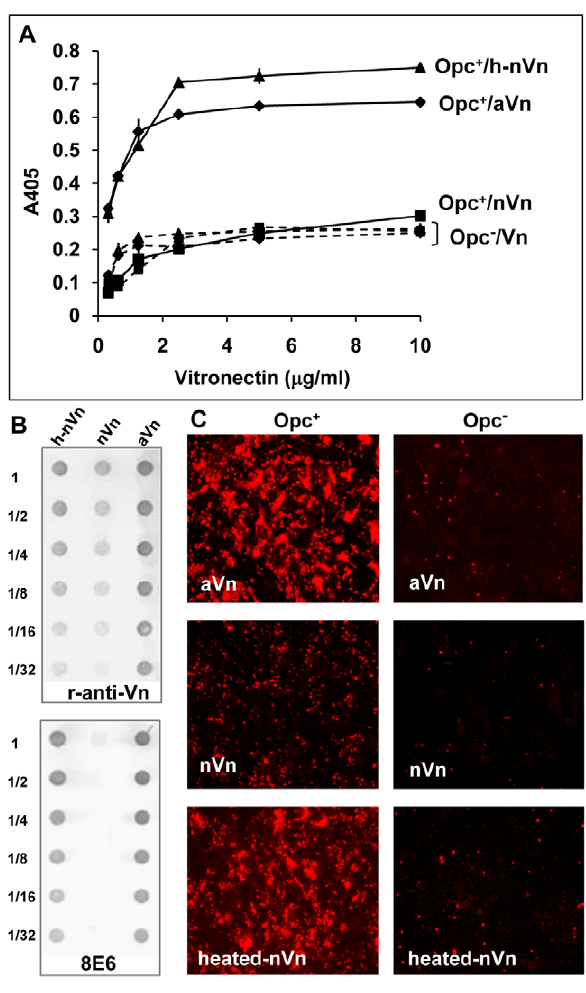
Figure 3. Deliberate modification of nVn conformation increases Opc–expressing meningococcal interactions with Vn and with HBMECs. (A) Purified native Vn (nVn) was subjected to limited heat denaturation to relax its folded conformation and reveal the mAb 8E6 binding site. To assess the levels of binding of Opc + Nm to nVn, heated nVn (h-nVn) and the serum-derived heparin-purified activated Vn preparation (mAb 8E6 binding form), these proteins were overlaid on to immobilised Opc + and Opc 2 isolates of strain C751 and Vn binding determined using polyclonal anti-Vn antibody. As bacteria lacking Opc exhibited the same level of binding to all vitronectin preparations, these are labelled as (Opc 2 /Vn broken lines). (B) The vitronectin samples used for ELISA were also analysed for their activation status using the mAb 8E6 and the polyclonal anti-Vn antibody (r-anti-Vn) by immuno-dot blotting. The conformation- dependent mAb 8E6 only reacted with aVn and heated nVn demonstrating the exposure of its epitope on heat treatment of nVn. Rabbit antibodies also bound more effectively to the same two forms of Vn suggesting that aVn and h-nVn present larger numbers of epitopes. (C) Immunofluorescence analysis was performed using confluent HBMECs infected with Opc + and Opc 2 C751 isolates in media supplemented with aVn, nVn and heated nVn illustrating their relative abilities in supporting bacterial adhesion. Bacteria were labelled using anti-Nm antiserum and rhodamine-conjugated secondary antibody.